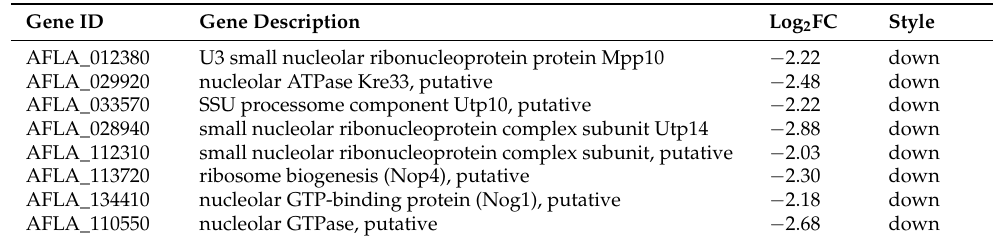
Figure 10. KEGG pathway classification of the screened differential genes. Table 5. Expression profiling of A. flavus genes involved in ribosome biogenesis in eukaryotes.